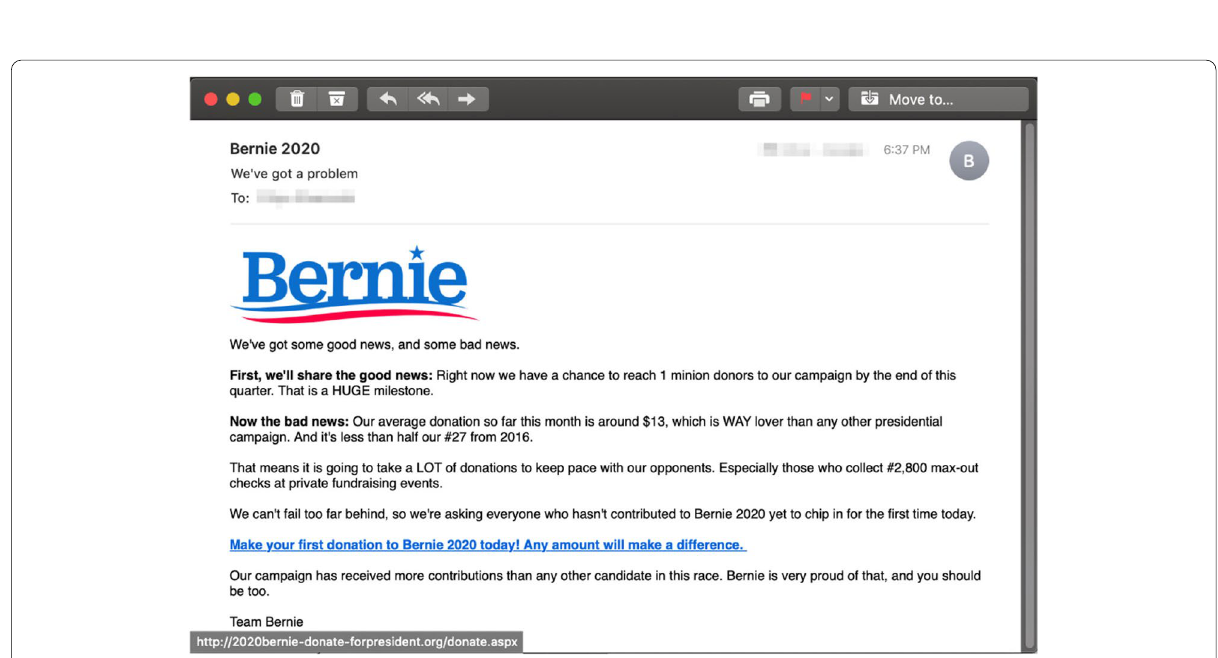
Fig. 4 Phishing email incorporating the commitment